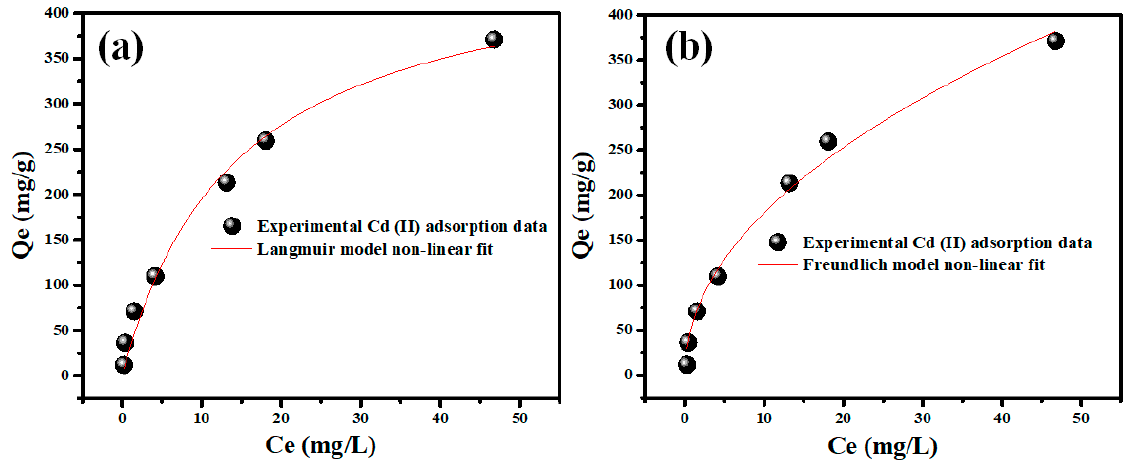
Figure 7. Effect of disparity pH on Cd (II) adsorption.